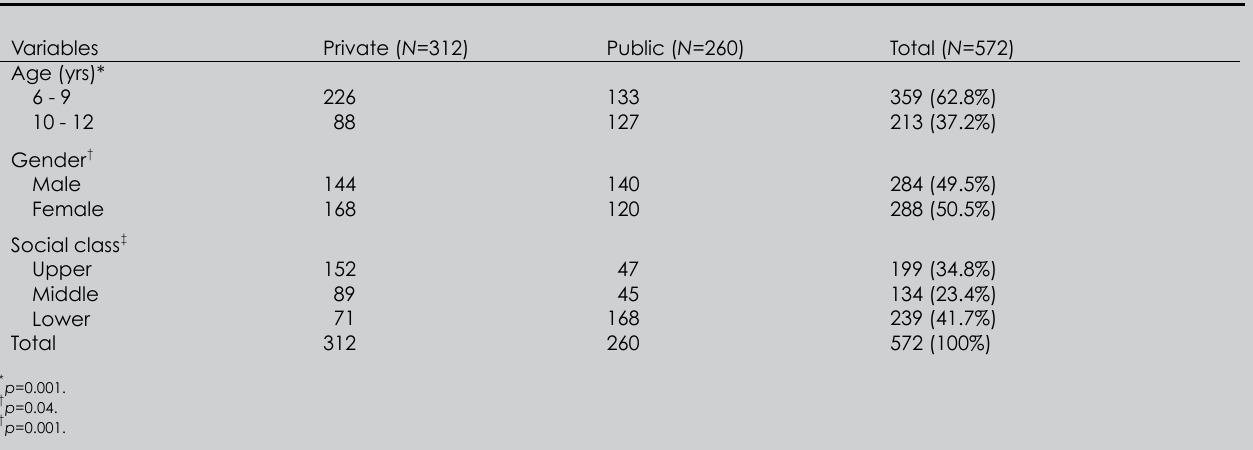
Table I. Age, gender and social class distribution of study population according to type of school Variables Age